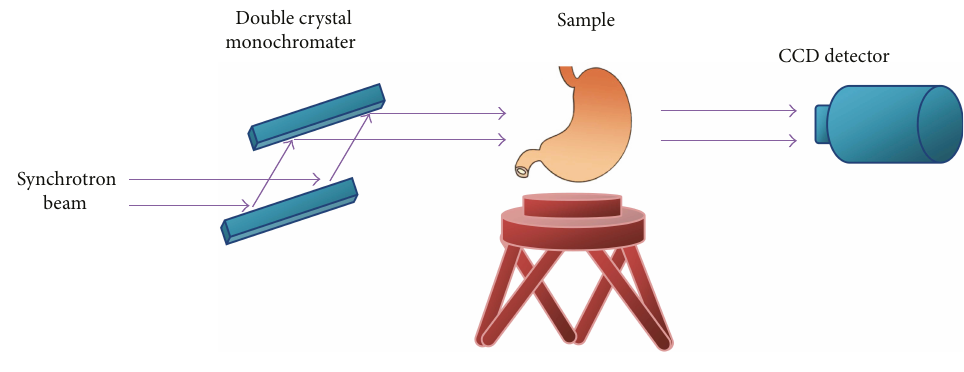
Figure 1: The schematic of imaging